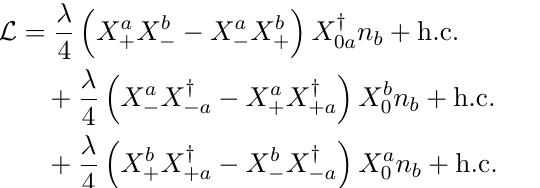
where we also dropped the superscript on n . For each dark color, X consists of